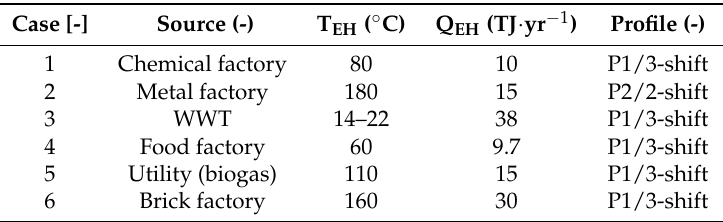
Table 5. Overview of the data retrieved from amongst others the GIS model for the EH sources used in the case studies.